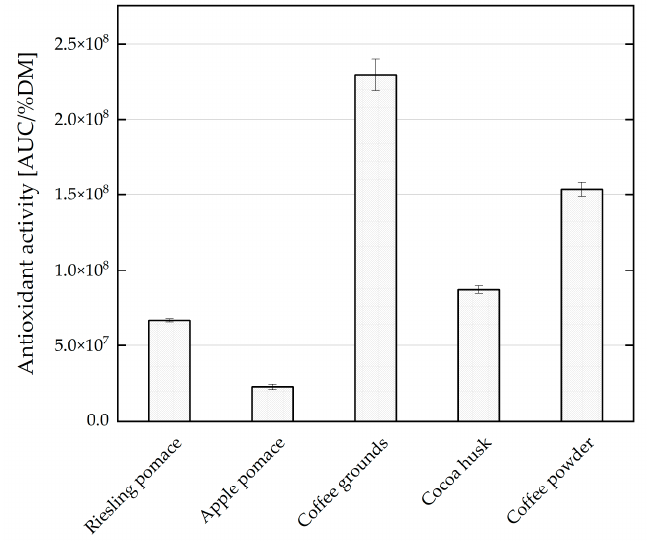
Figure 2. Antioxidant activity of extracts measured with ORAC assay.